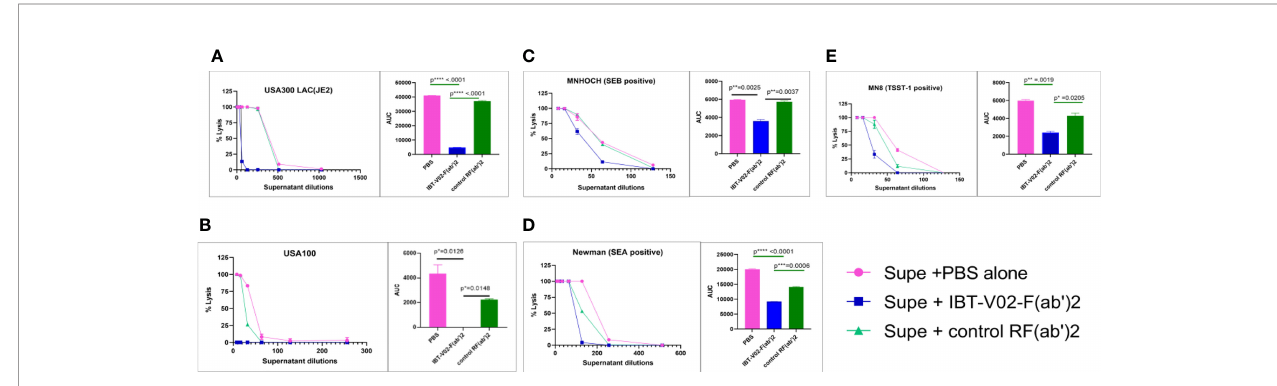
FIGURE 8 | The bacterial culture supernatant neutralization by IBT-V02-F(ab ’ 2) in RRBC hemolytic assay. (A) USA300 LAC JE2, (B) USA100, (C) MNHOCH, (D) Newman, and (E) MN8 neutralization by F(ab ’ )2. In each fi gure, the AUC is shown as an inset. The data were analyzed by unpaired t-test. p- values are represented as: ns, P > 0.05; *, P ≤ 0.05; **, P ≤ 0.01; ***, P ≤ 0.001; ****, P ≤